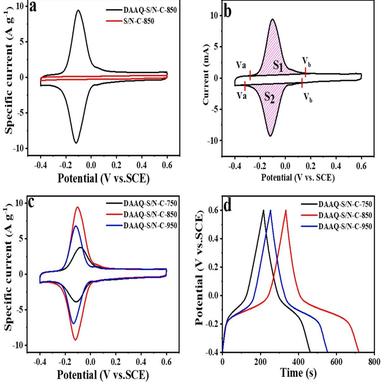
(a) CV curves of DAAQ-S/N-C-850 and S/N-C-850 electrode materials. (b) CV curves of DAAQ-S/N-C-850 to quantitatively determine the content of DAAQ. (c) CV curves of DAAQ-S/N-C-750, DAAQ-S/N-C-850, and DAAQ-S/N-C-950 samples at 5 mV s − 1 . (d) GCD profiles of DAAQ-S/N-C-750, DAAQ-S/N-C-850, and DAAQ-S/N-C-950 electrodes in current density of 1 A g− 1 .